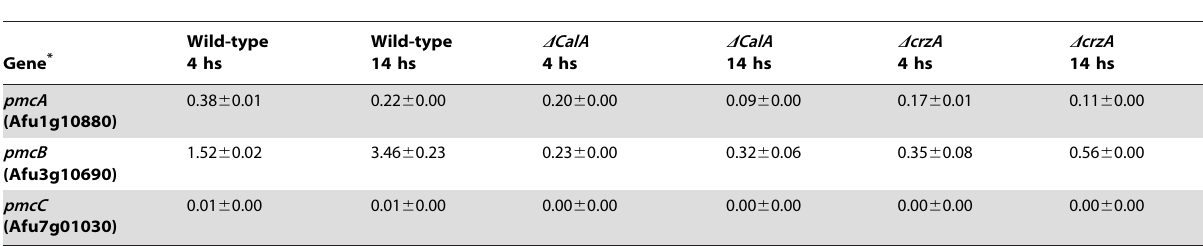
Table 1. Real-time RT-PCR for pmcA-C genes from the in vivo